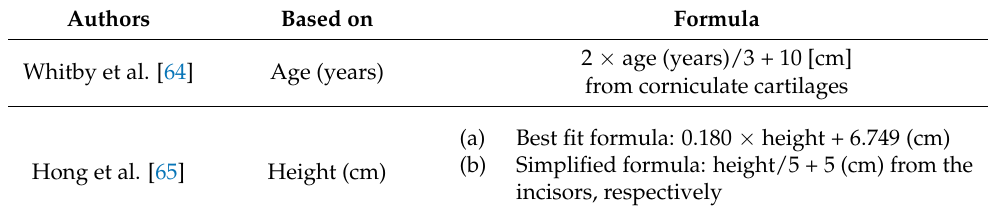
Table 1. Formulas to estimate oesophageal temperature probe insertion depth in